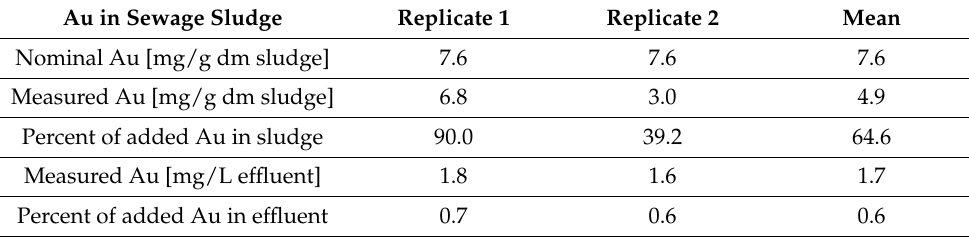
Table 2. Fate of Au in the sewage treatment plant (STP): Measured gold concentration in activated sludge and effluent.